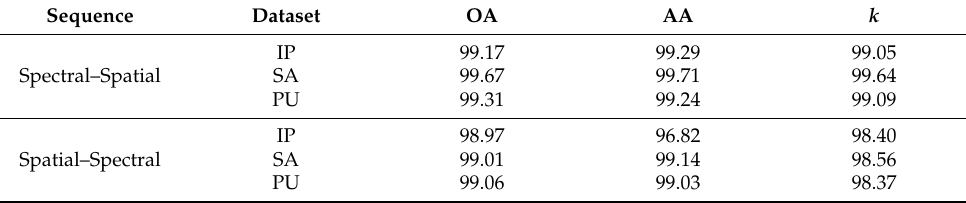
Table 11. Ablation study of swapping the sequence of spectral and spatial modules of SSCRN. Sequence